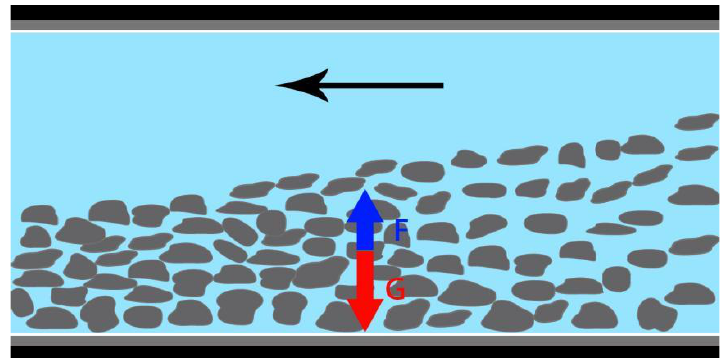
Figure 5. Forces imposed on the solid aggregate during transportation.